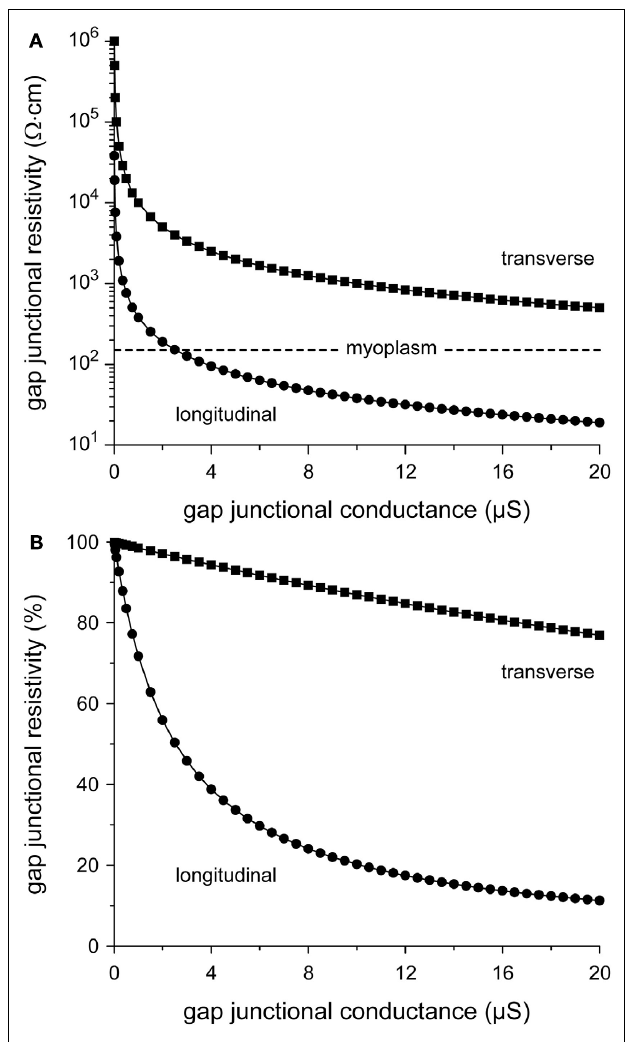
FIGURE 3 | Relation between gap junctional resistivity and gap junctional conductance for longitudinal (circles) or transverse arrangement of cells (squares). (A) Gap junctional resistivity in Ω ·cm. Dashed horizontal line indicates the myoplasmic resistivity of 150 Ω cm. Note logarithmic ordinate scale. (B) Gap junctional resistivity expressed as percent of total